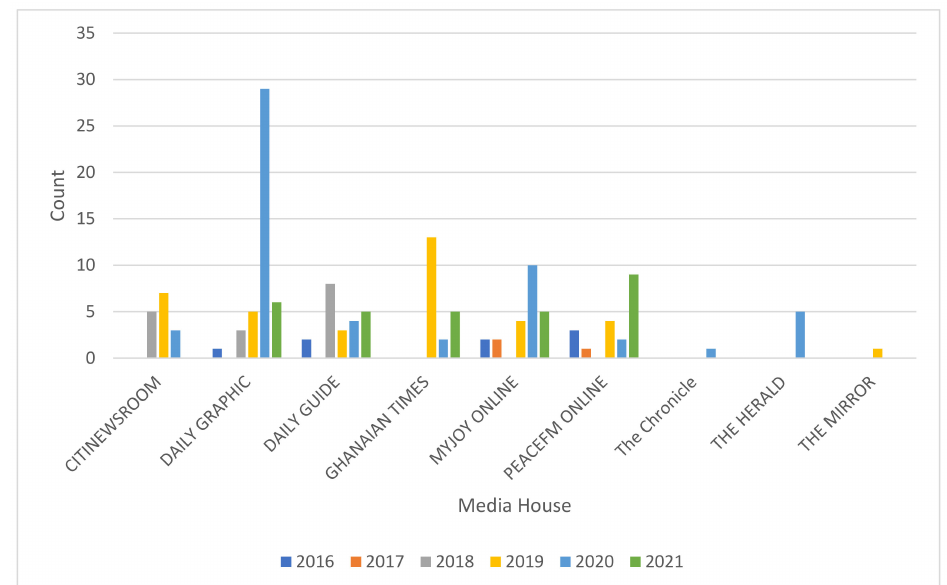
Figure 3. Air pollution publications by Media house per year from